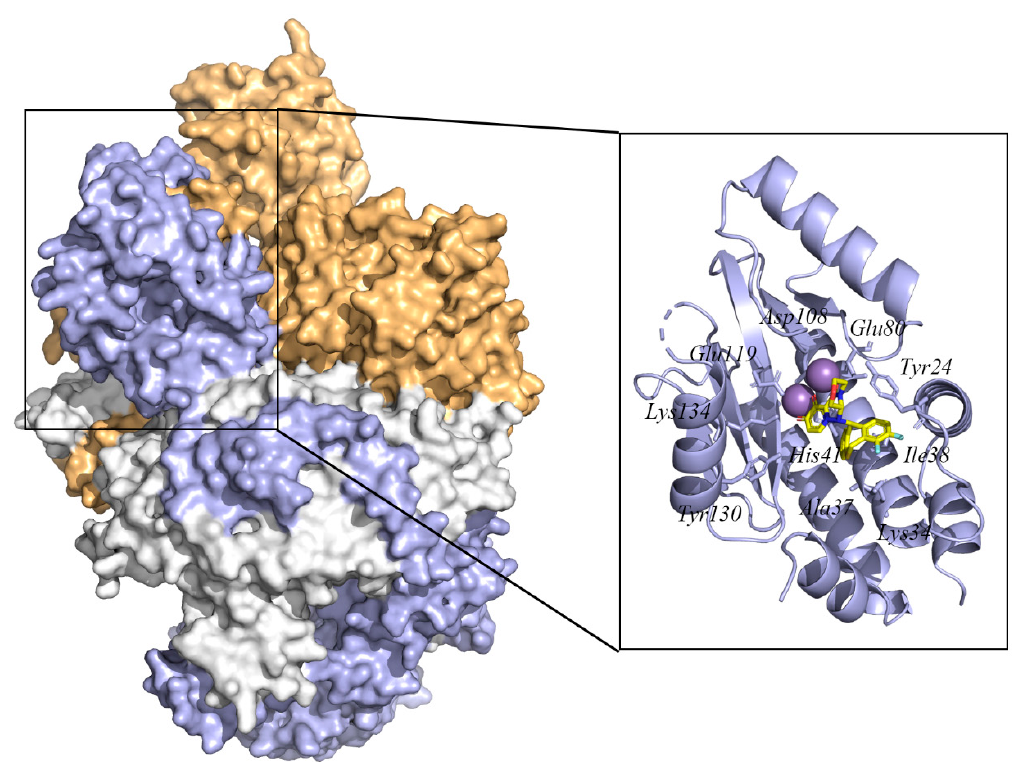
Figure 3. The surface structure of the influenza A virus RNA-dependent RNA polymerase complex (PB2, PB1, and PA) (PDB ID: 6QPF) [62] and the cartoon structure of PA endonuclease with inhibitor baloxavir acid (PDB ID: 6FS6) [63]. In the polymerase complex, the PA domain is colored blue, the PB1 domain is colored white, and the PB2 domain is colored orange. The residues in the PA endonuclease active site are indicated by blue sticks. The baloxavir acid is colored yellow. The Mn ions are indicated with violet spheres. The protein structure was displayed and analyzed through the PyMOL visualization program [69–71].